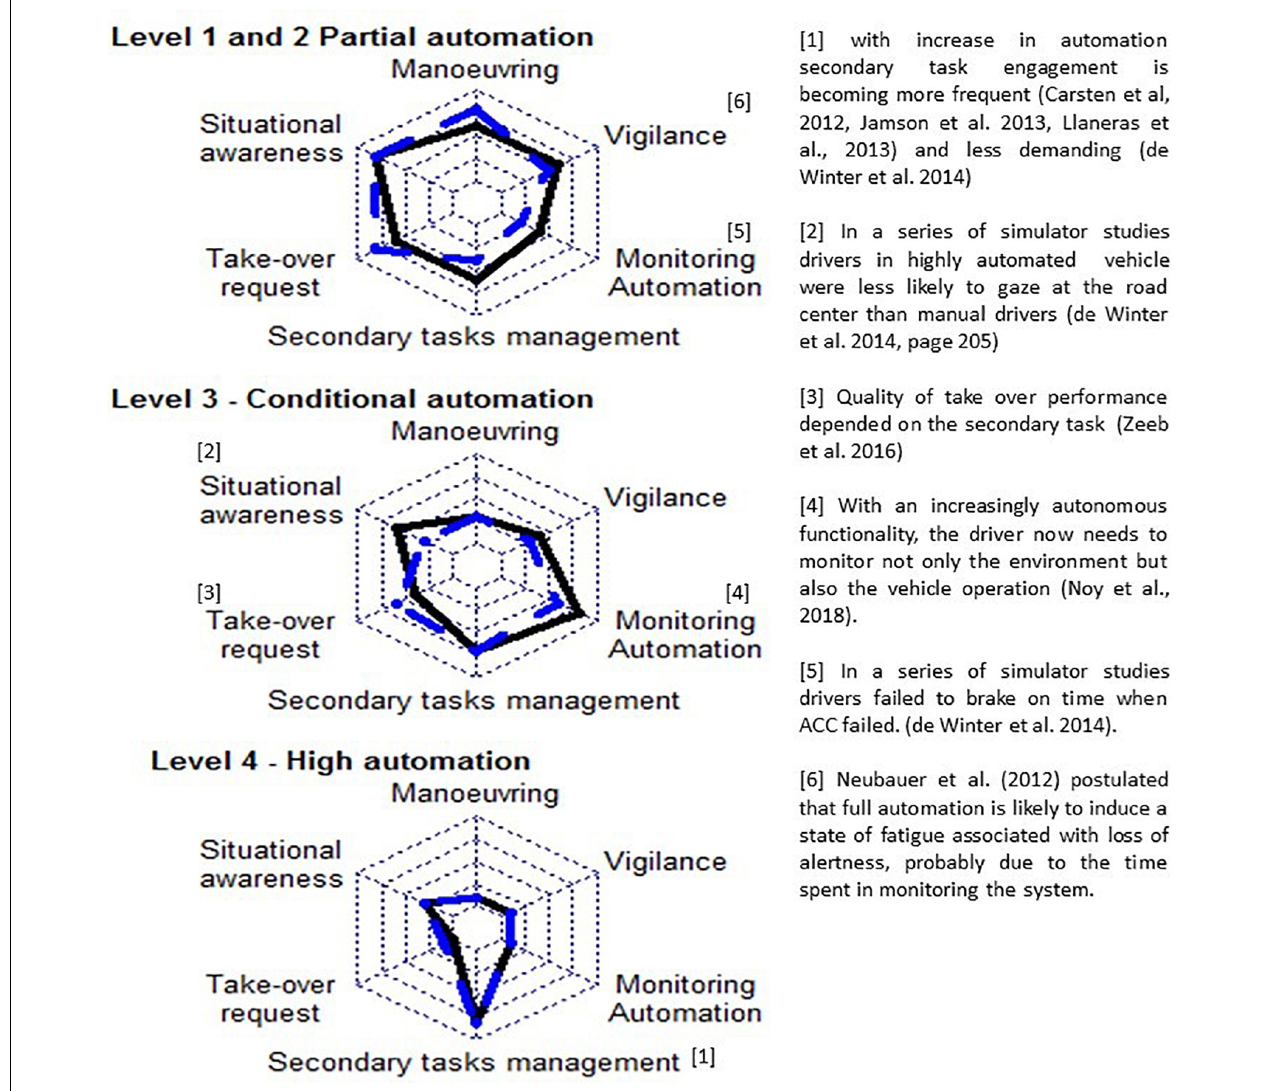
FIGURE 1 | Illustration of required capacities (black) and available capacities (blue) by level of automation (subplot). Level 5 is not present in the figure since driver involvement is not required in complete